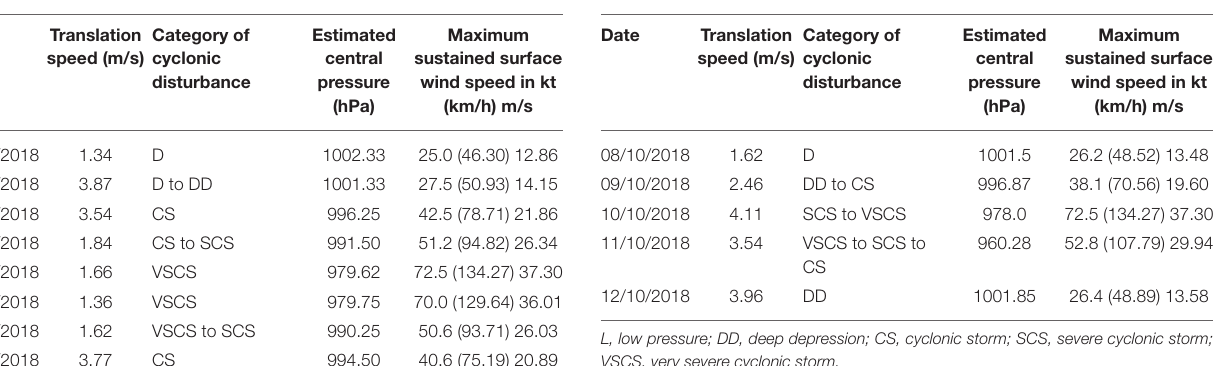
TABLE 1 | Daily mean characteristics of the cyclone Luban in the Arabian Sea (AS) during its genesis and evolution.